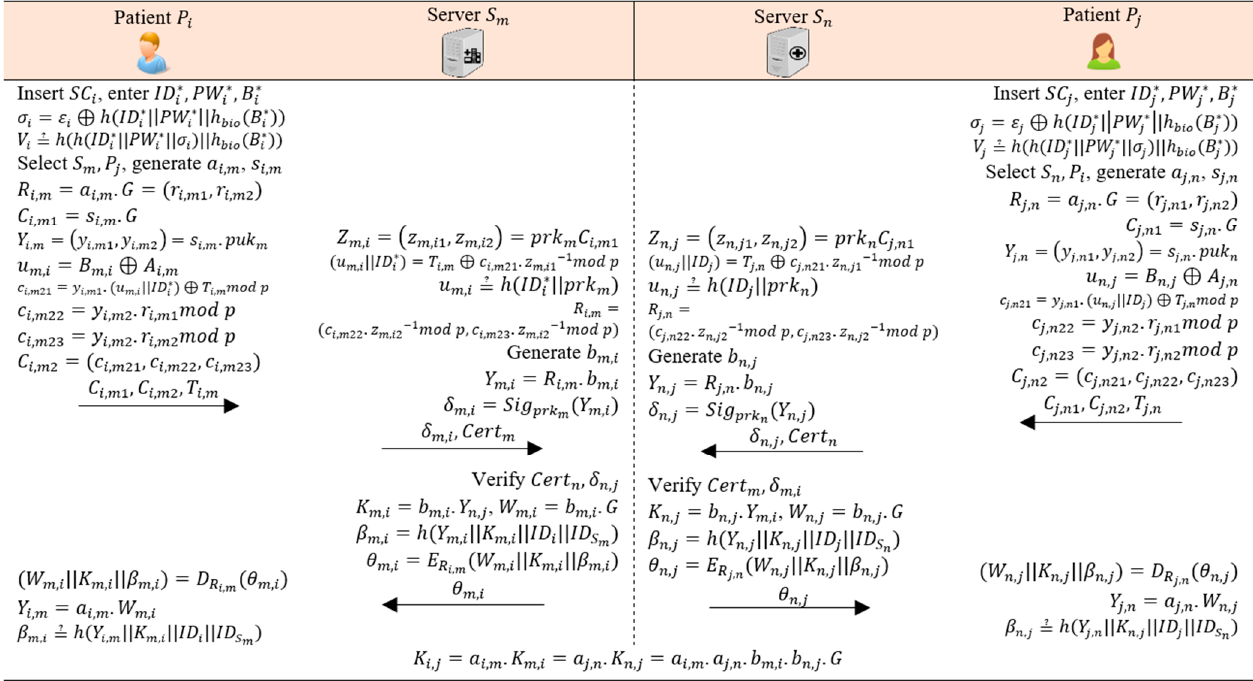
Figure 3. Login and authentication procedure of the proposed protocol.